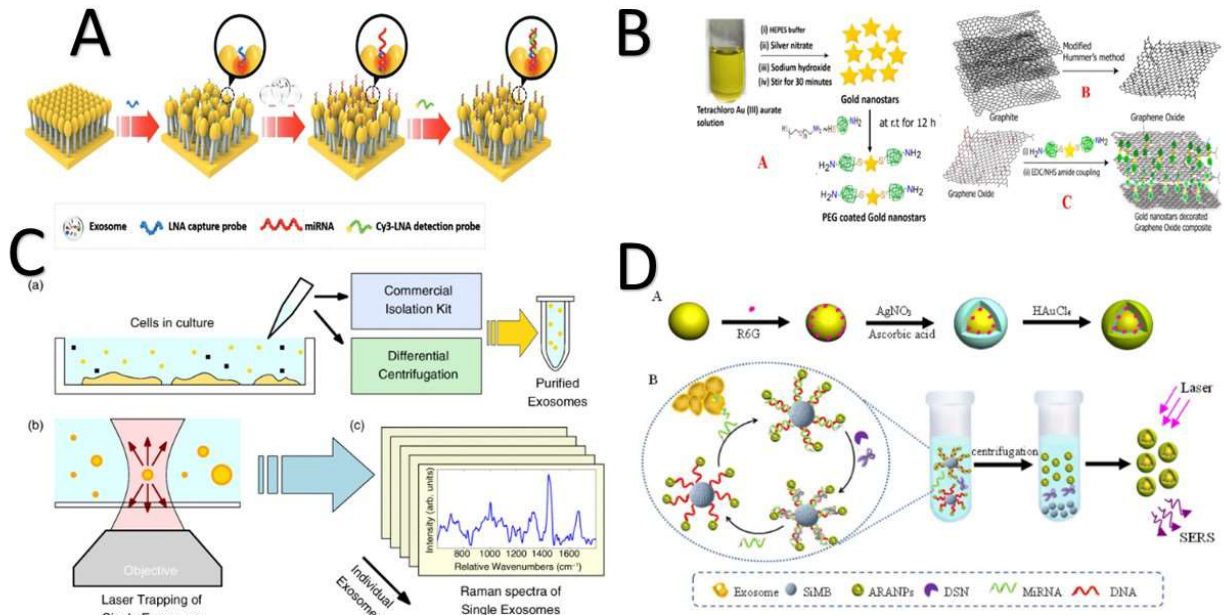
Figure 7. Examples of Raman scattering techniques for exosome detection and quantification. The figure permissions are as follows: ( A ) license number 5071621135225, license date May 17, 2021, licensed content publisher John Wiley and Sons. Licensed content publication of “Quantitative and Specific Detection of Exosomal miRNAs for Accurate Diagnosis of Breast Cancer Using a Surface-Enhanced Raman Scattering Sensor Based on Plasmonic Head-Flocked Gold Nanopillars”. ( B ) Adapted with permission from Pramanik, A. et al. 2020. Mixed-dimensional heterostructure material-based SERS for trace level identification of breast cancer-derived exosomes. ACS omega, 5(27), pp. 16602–16611. Copyright (2021), hps://pubs.acs.org/doi/10.1021/acsomega.0c01441, and further permissions related to the excerpted material should be directed to ACS. ( C ) Adapted from Smith, Z.J. et al. 2015. Single exosome study reveals subpopulations distributed among cell lines with variability related to membrane content. Journal of extracellular vesicles , 4(1), p. 28533. The work was made